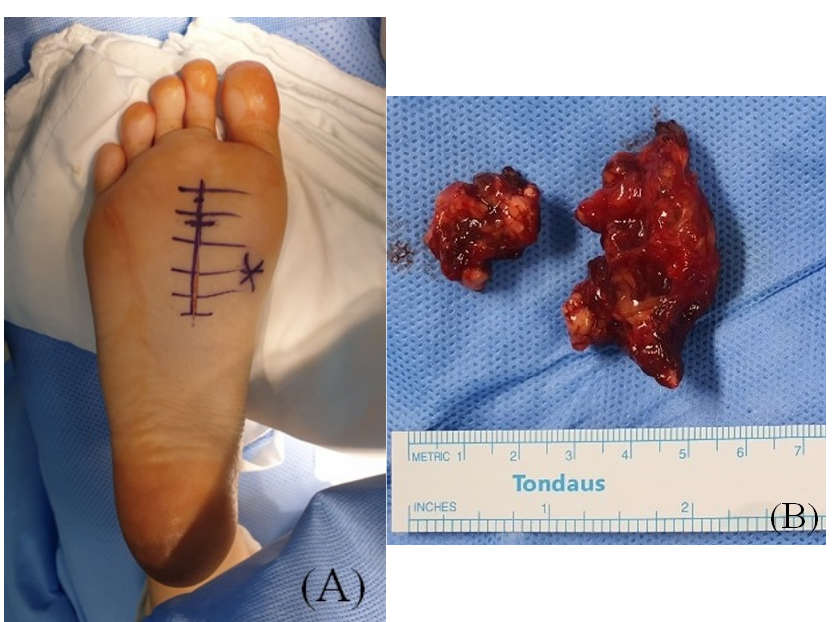
Figure 3. ( A ) Preoperative clinical photographs and incision site. ( B ) Intraoperative photographs of the excised mass.